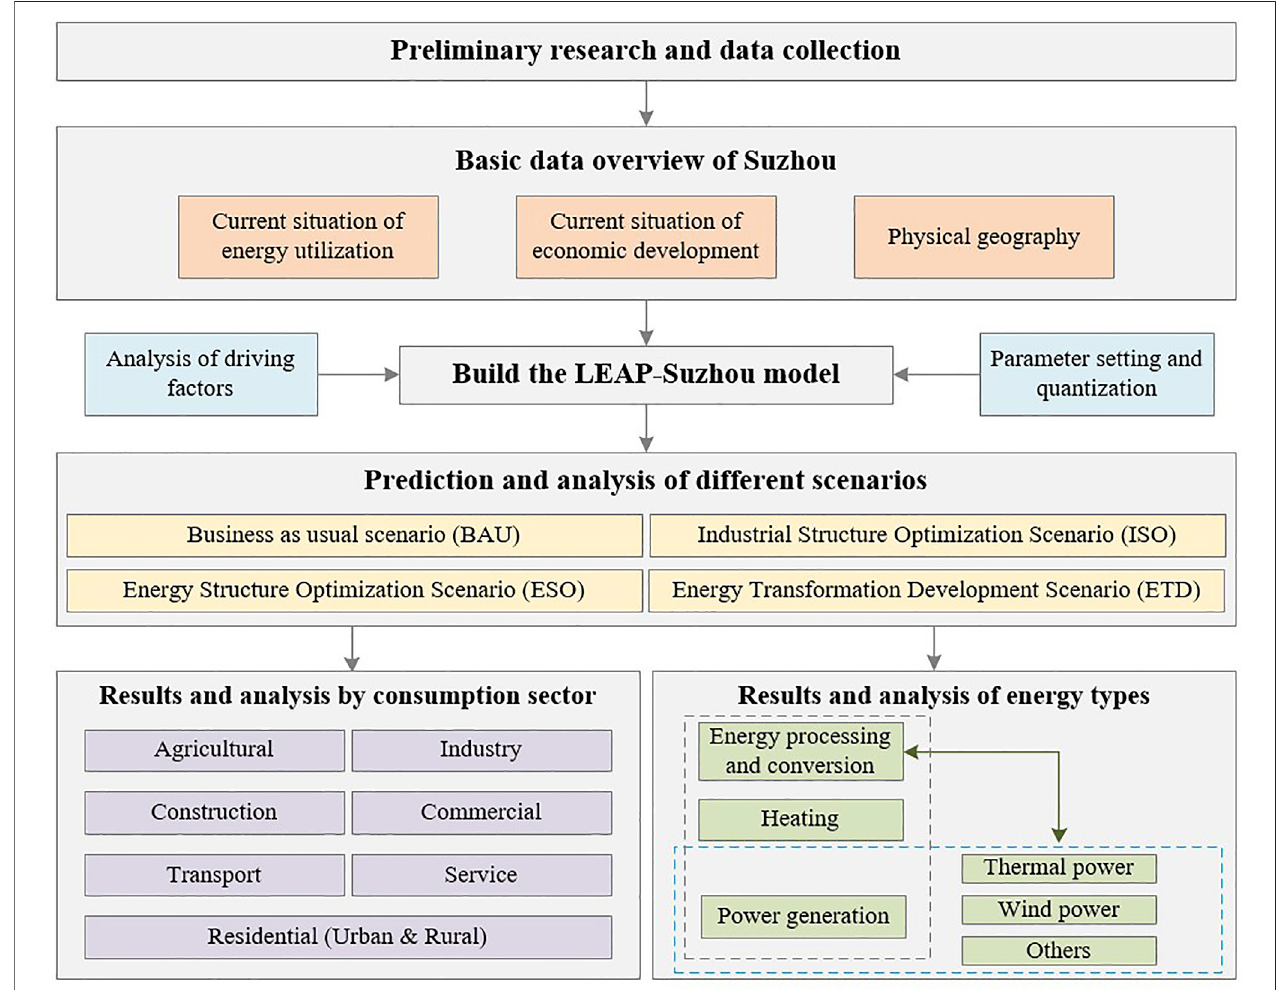
FIGURE 2 | Analysis framework of Energy consumption in Suzhou.